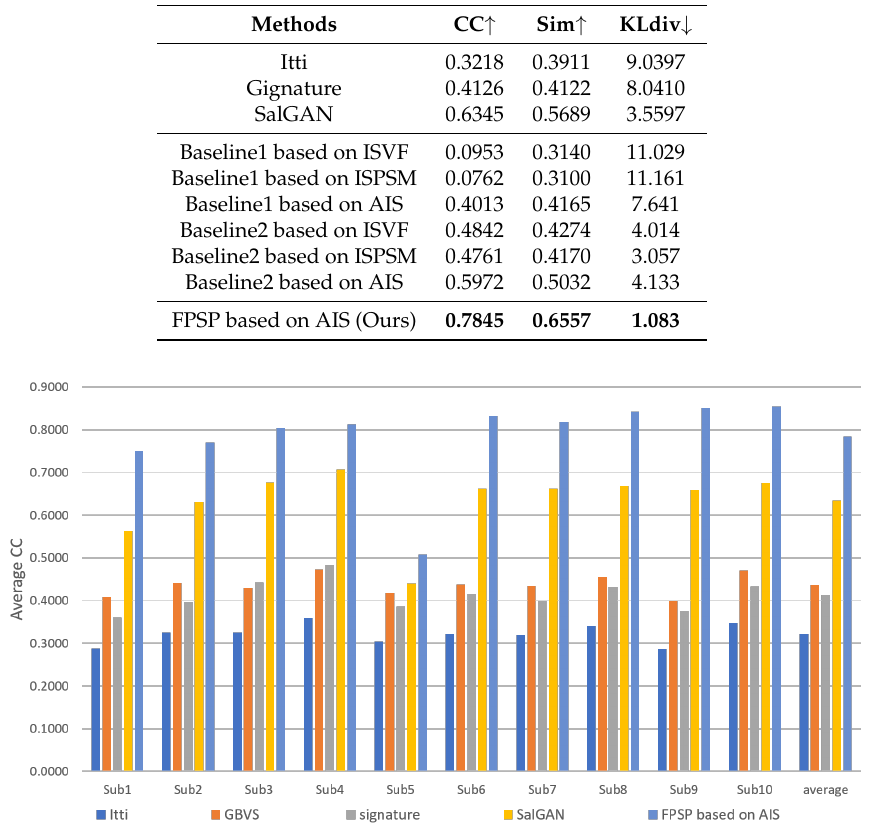
Figure 5. Qualitative results for one person predicted by the FPSP and the comparative methods. In this figure, training images of baselines 1 and 2 and FPSP were selected by AIS. Table 2. Comparison of performance in multiple evaluation indices. The mark ( ↑ ) means that the higher the index becomes, the higher the performance increases. Similarly, the mark ( ↓ ) means that the lower the index becomes, the higher the performance increases. Note that 100 (= C ) selected images were used for training in baselines 1 and 2 and FPSP. It should be noted that the bold font represents the highest value in its evaluation index.